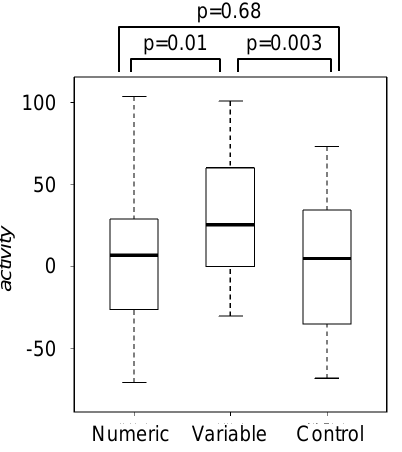
Fig. 8. Brain activity of each question in Program task.